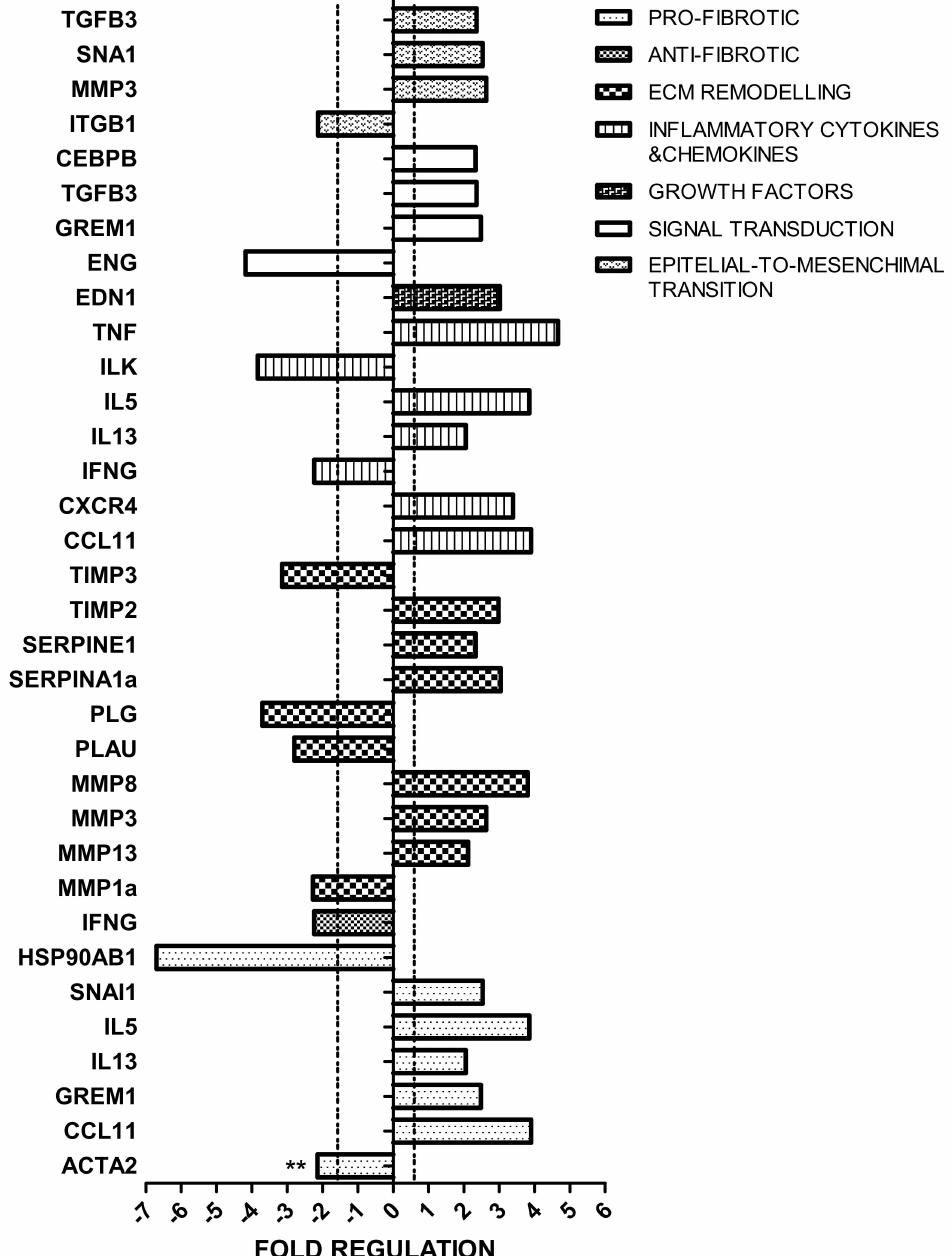
Figure 2. Fibrosis-related transcriptome in high-fat (HF) vs. normal chow (CTR) group. Gene expression profile was evaluated using the mouse Fibrosis RT 2 Profiler PCR Array. Genes that showed a fold change >2 or < − 2 in the HF vs. CTR group are represented and grouped according to their biological function. ** p <